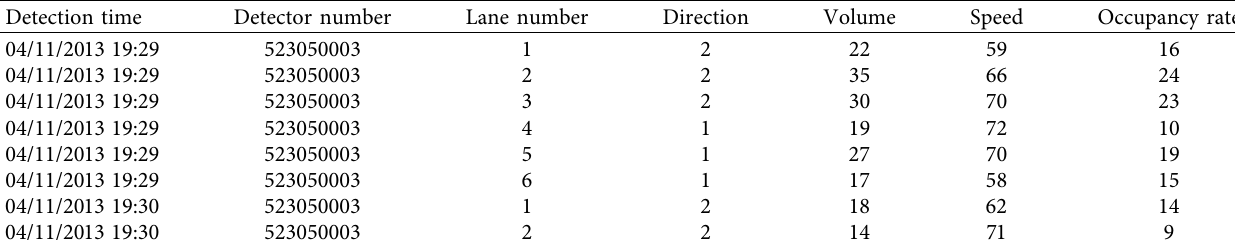
Table 2: Examples of partial trafc fow data.